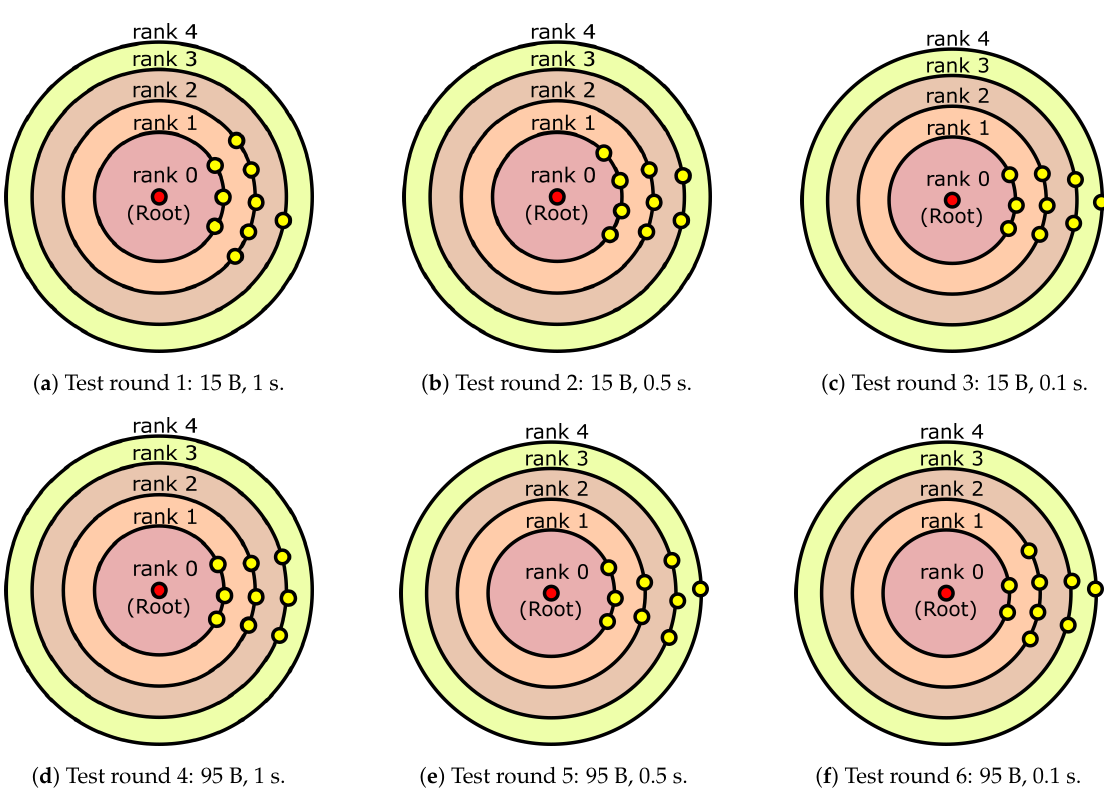
Figure 13. Node rank distribution generated for rounds 1 to